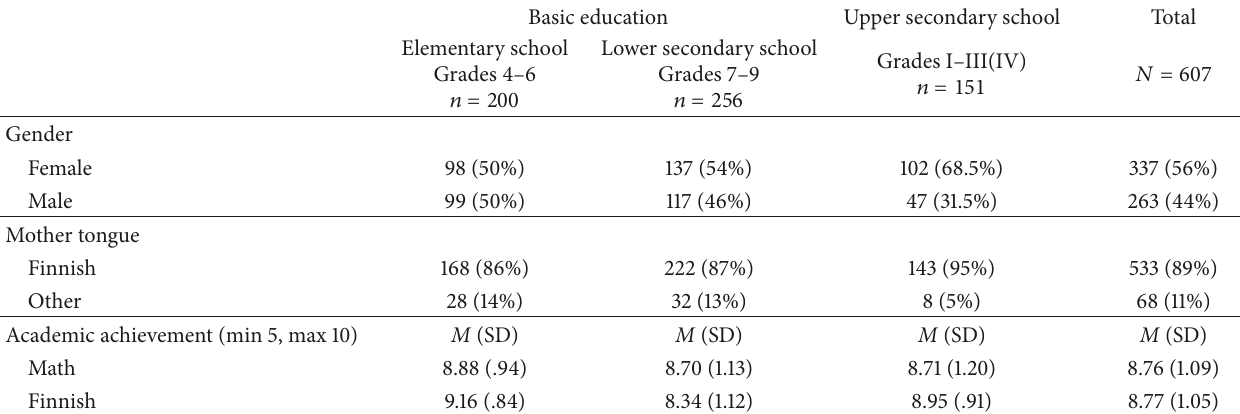
Table 1: Participating students at the Viikki Teacher Training